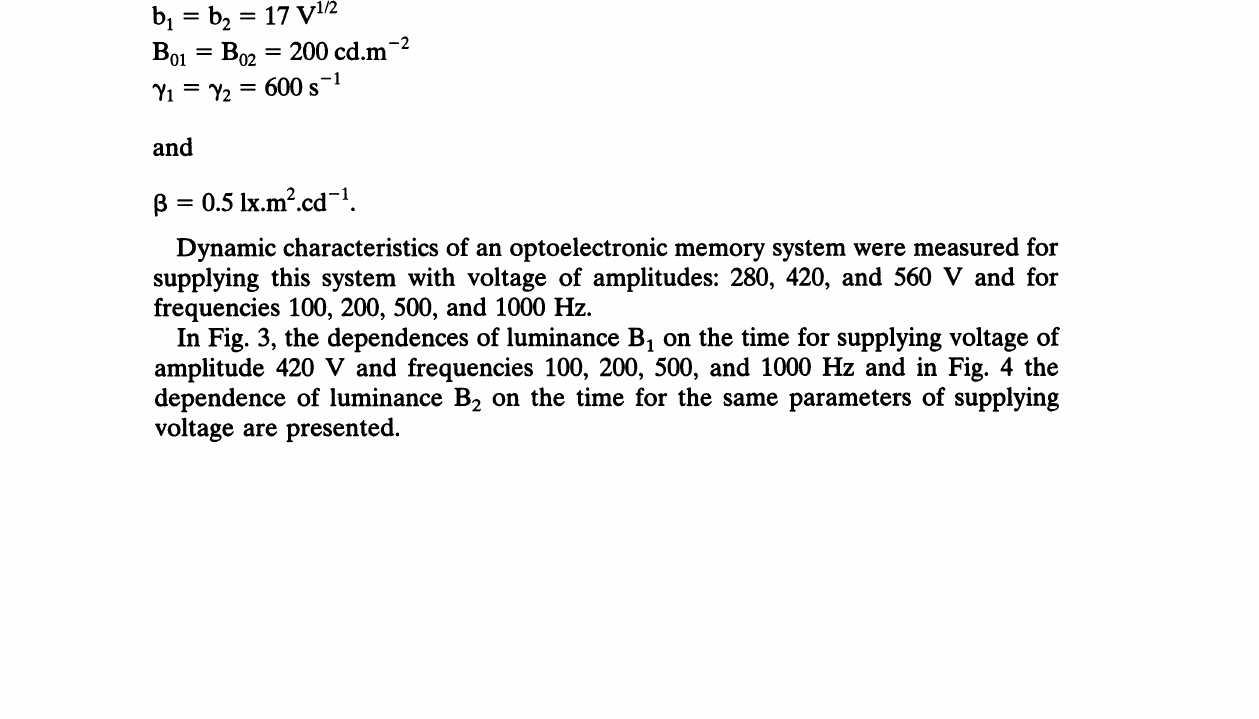
FIGURE 2 Arrangement of the thin film PC-EL systems of an optoelectronic memory element. manganese-doped ZnS